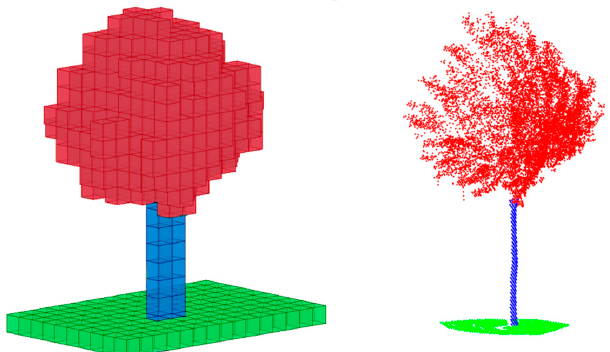
Figure 4. Pole object extraction. ( Left ): group of voxels defining the actual pole (blue), linked voxels conforming the object attached to the pole (red), and voxels containing points on the ground (green); ( Right ): points inside each voxel group that inherit the voxel labels.